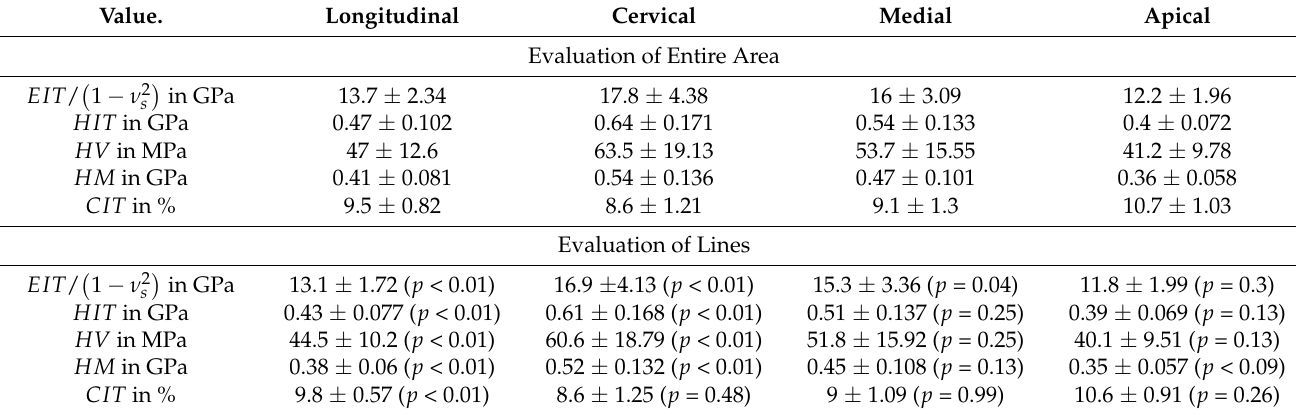
Table 1. Statistical evaluation of the mandibular molar (mean value ± standard deviation (probability value p )).